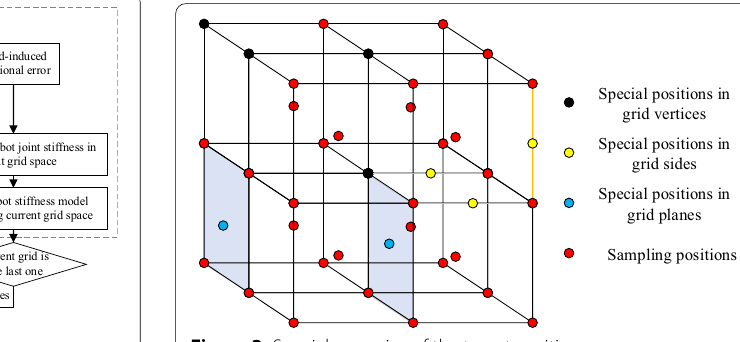
Figure 2 Flowchart of variable stiffness identification